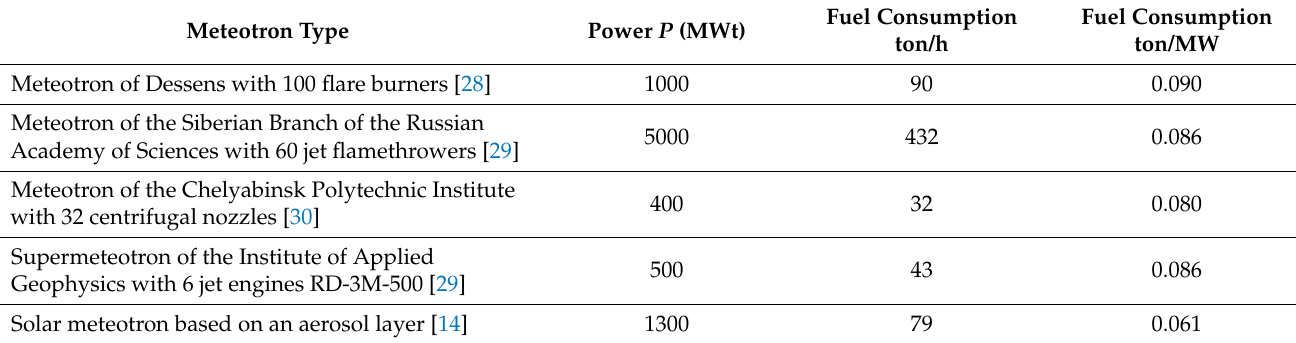
Table 2. The power of various meteotrons and the consumption of combusted